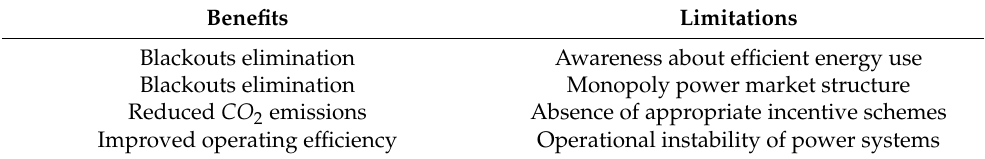
Table 1. DSM insight.